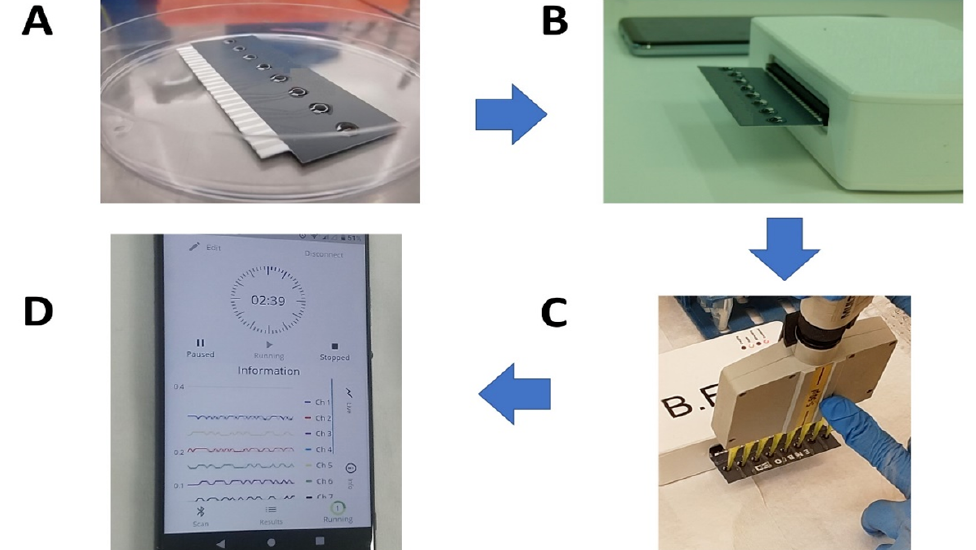
Figure 2. Experimental set-up of the membrane-engineered cell-based biosensor’s assembly. Eight- channel carbon screen-printed electrodes were prepared with custom-made hydrogel-immobilized membrane-engineered cells ( A ). The electrode containing the 3D cell cultures was placed to the mea- surement device ( B ). Each sample was applied (8 × ) to the testing positions (cell-covered electrodes) while the electrode strip was connected to a bespoke portable potentiometer which is connected to a tablet device for the recording of the measurements immediately after the sample application ( C ). The electric signal is continuously visualized through a voltage vs. time graph on the screen of a smartphone connected via Bluetooth to the device ( D